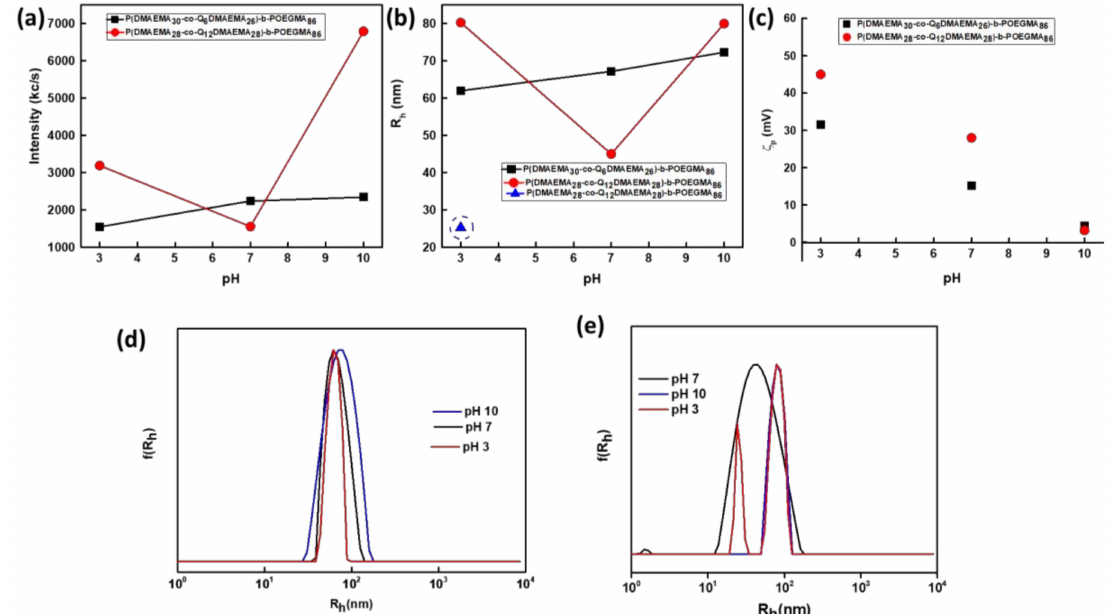
Figure 6. Dependence of ( a ) scattering intensity (I), ( b ) hydrodynamic radius (R h ) and ( c ) surface charge ( ζ p ) for the P(DMAEMA 30 -co-Q 6 DMAEMA 26 )- b -POEGMA 86 and P(DMAEMA 28 -co-Q 12 DMAEMA 28 )- b -POEGMA 86 aqueous solutions on pH-variations and size distributions from CONTIN analysis obtained at 90 o , at pH 7, 3 and 10 for ( d ) P(DMAEMA 30 -co- Q 6 DMAEMA 26 )- b -POEGMA 86 and ( e ) P(DMAEMA 28 -co-Q 12 DMAEMA 28 )- b -POEGMA 86. The preparation protocol via